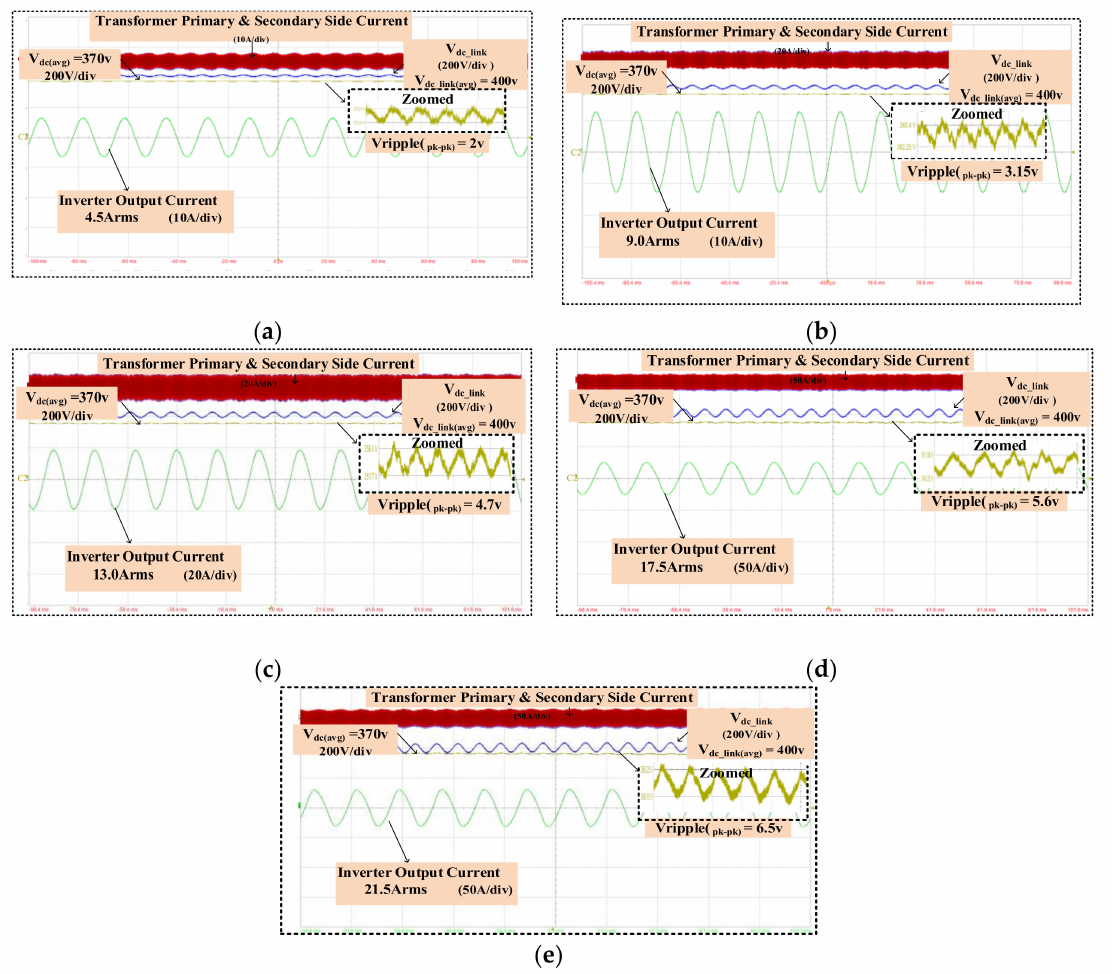
Figure 13. Experimental waveforms with the proposed double line frequency ripple elimination method (from top to bottom: transformer primary & secondary side current, dc-link voltage, input source voltage, inverter output current): ( a ) 1 kW; ( b ) 2 kW; ( c ) 3 kW; ( d ) 4 kW; ( e ) 5